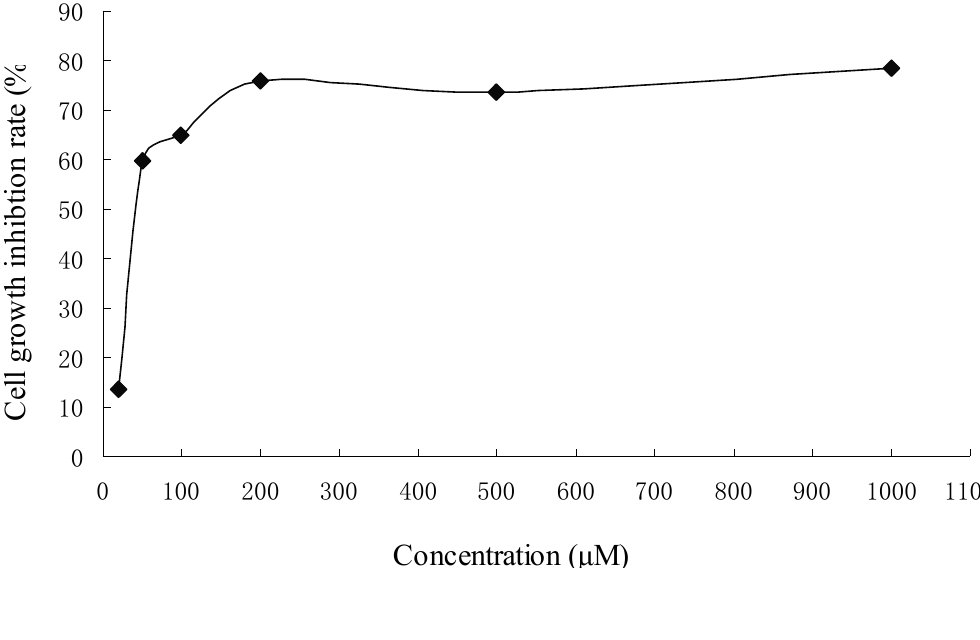
Figure 2. Effect of 4 ′ ,7-diacetoxyapigenin on Hep G2 cell proliferation.